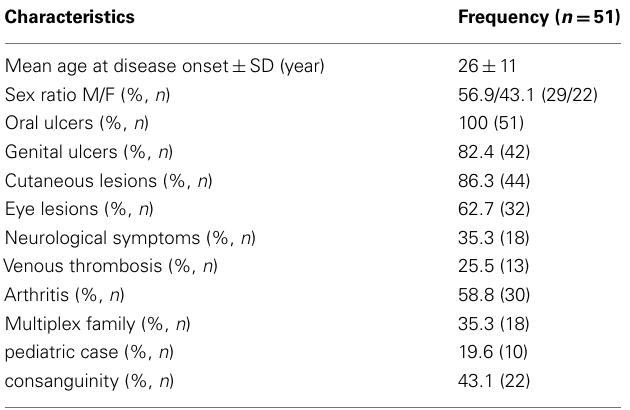
Table 2 | Clinical and demographic features of the Behçet patients of the current study.